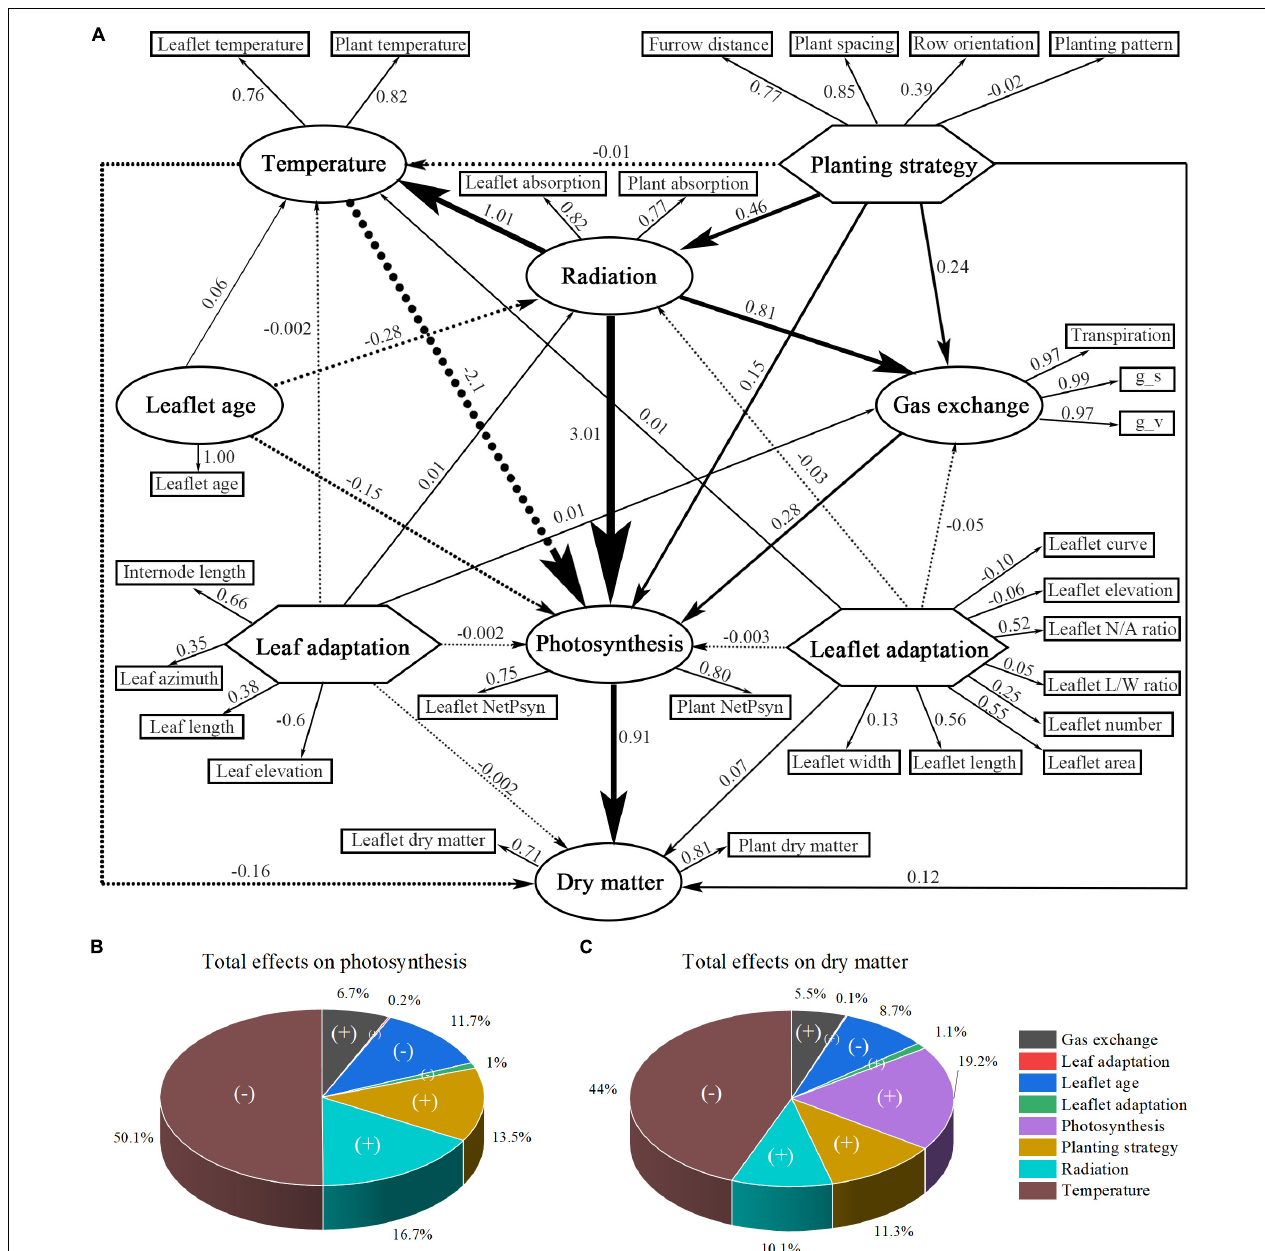
FIGURE 14 | Partial least-squares path modeling (PLS-PM) of all collected physiological and morphological data (A) . The finalized version of the PLS-PM is shown. Simulated variables are represented in a rectangle form, while traits within the big circles and polygons are latent variables. Indicated are the loadings (the correlations between a latent variable and its simulated variables) and the path coefficients calculated after 1,000 bootstraps. Total effects of different latent values on the outputs of the PLS-PM: photosynthesis (B) and yield (C) . (+) indicates a positive effect while (–) indicates a negative effect. Percentages are the proportion of path weights contributing to each